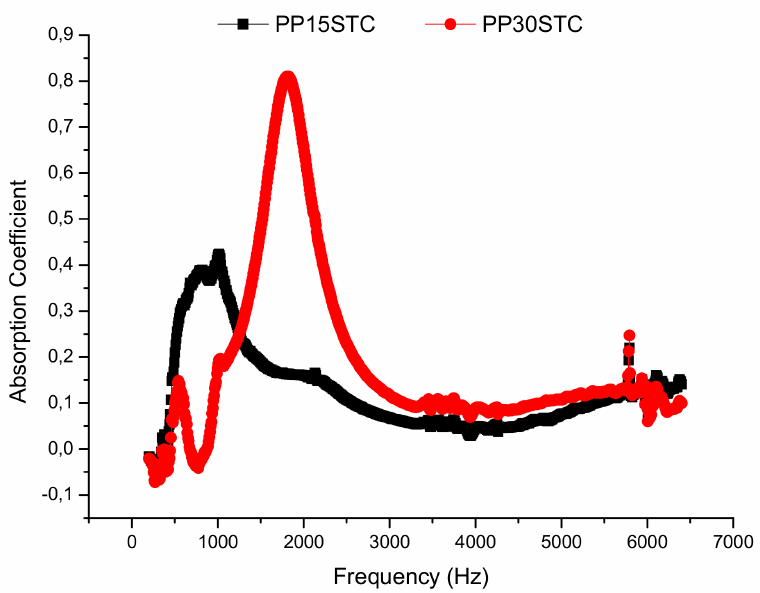
Figure 6. The absorption performances of 30 and 50 mm Placuna placenta with Side-Tailed